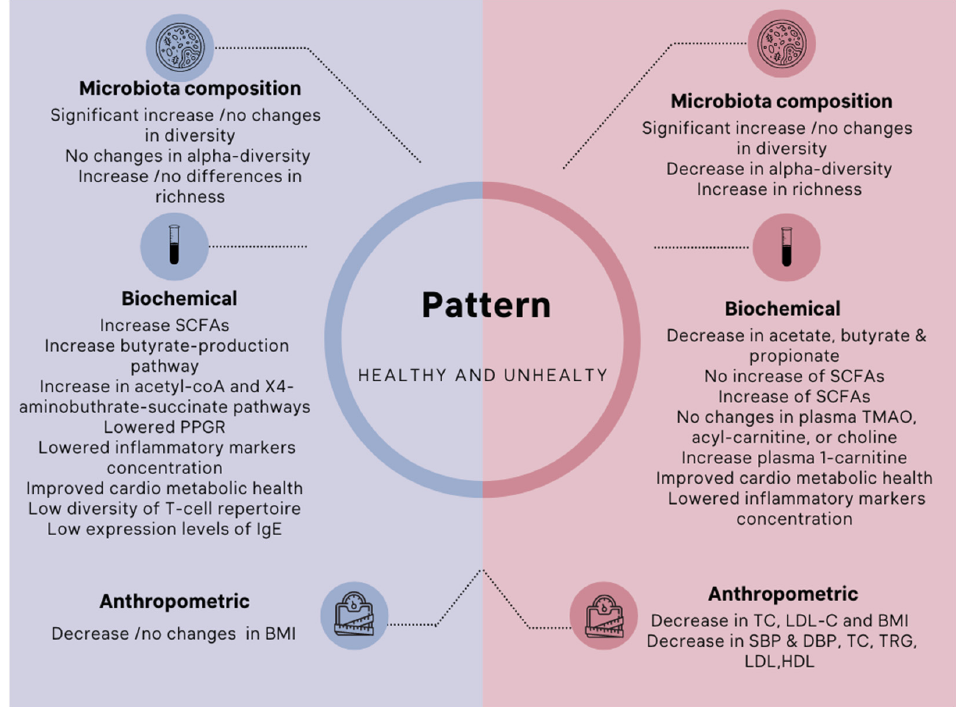
Figure 4. The influence of vegan/vegetarian diets on gut microbiota composition and biochemical and anthropometric levels in the healthy and unhealthy (metabolic and autoimmune disturbed) subjects. Note: short-chain fatty acids (SCFAs), postprandial (post-meal) glycemic response (PPGR), systolic blood pressure (SBP), diastolic blood pressure (DBP), total cholesterol (TC), triglycerides (TRG), low-density lipoprotein (LDL), high-density lipoprotein (HDL), low-density lipoprotein-